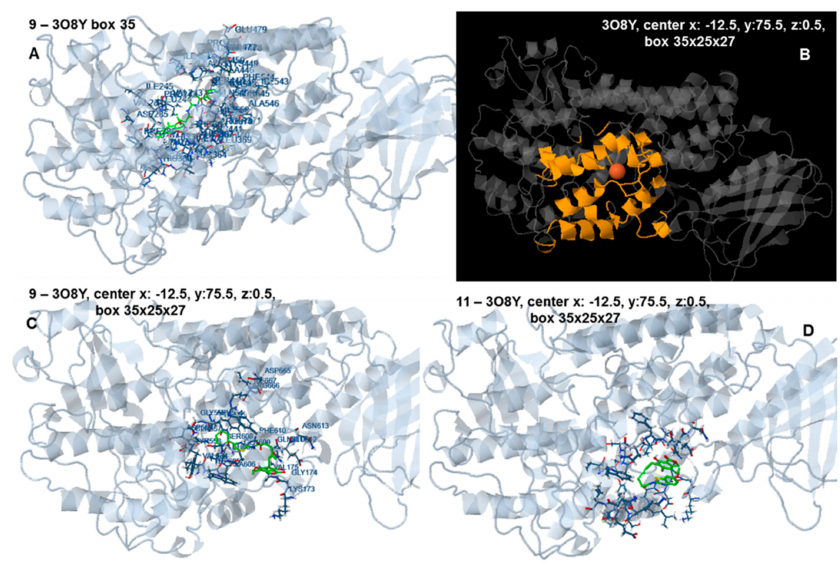
Figure 10. ( A ) Docking of compound 9 to the human 5-LOX structure 3O8Y, target center: x = 8.59 Å y = 22.65 Å, z = − 1.02 Å, target box 35 × 35 × 35 Å. The target box enables the compound to dock preferentially at the upper left corner, behind the active site; ( B ) Structure 3O8Y with the target box in yellow (center x: − 12.5 Å, y: 75.5 Å, z: 0.5 Å, box 35 × 25 × 27 Å); ( C ) Docking of compound 9 to 3O8Y (center x: − 12.5 Å, y: 75.5 Å, z: 0.5 Å, box 35 × 25 × 27 Å); ( D ) Docking of compound 11 3O8Y